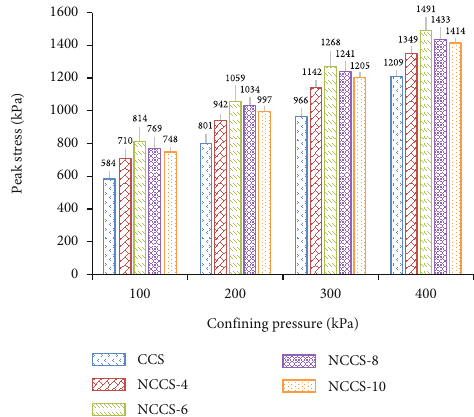
Figure 2: Relation of nanoclay content and peak stress of NCCS. Table 5: Peak strain of CCS and NCCS (%). Nanoclay content/%